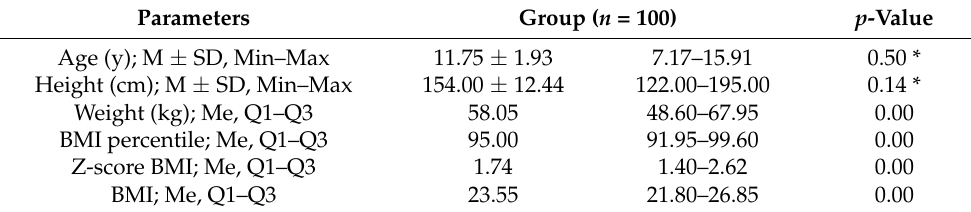
Table 1. Demographic and anthropometric parameters in the study